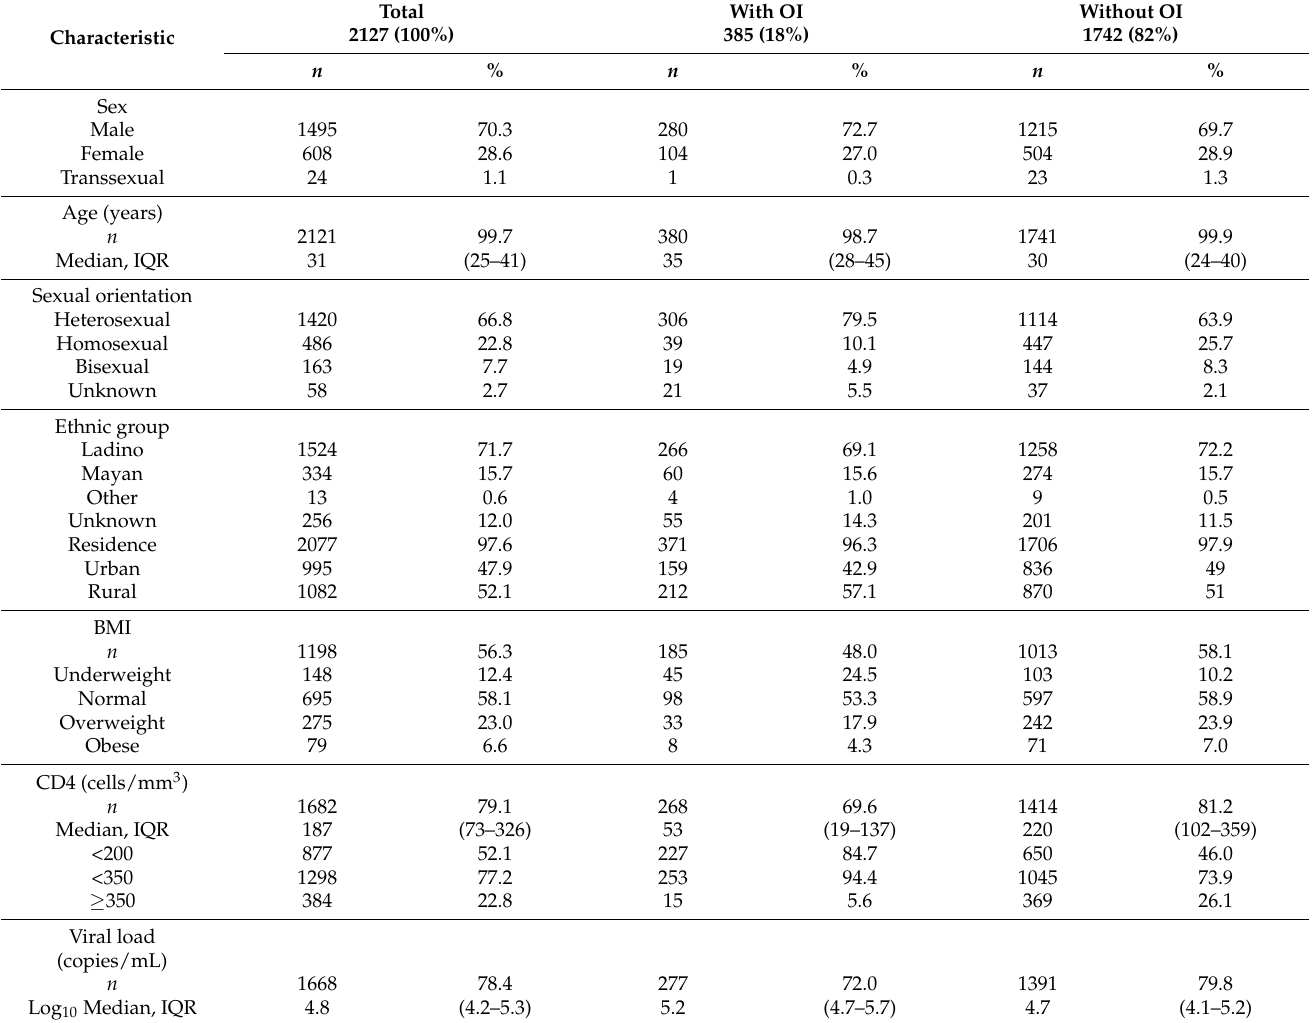
Table 1. Baseline characteristic of newly diagnosed HIV